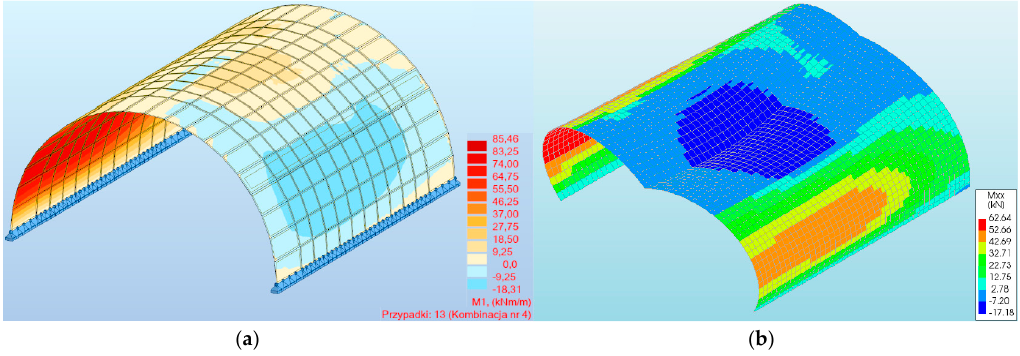
Figure 5. Maximum bending moments of a three-hinged arch for program: ( a ) #1, ( b ) #2.